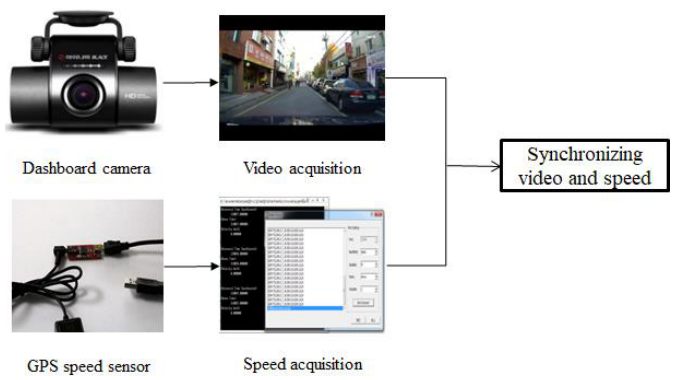
Figure 2. The speed information obtained from an external GPS module is written to a text file with the PC clock time. The speed information is synchronized with the video input from the on-dash camera in a car using the PC clock time